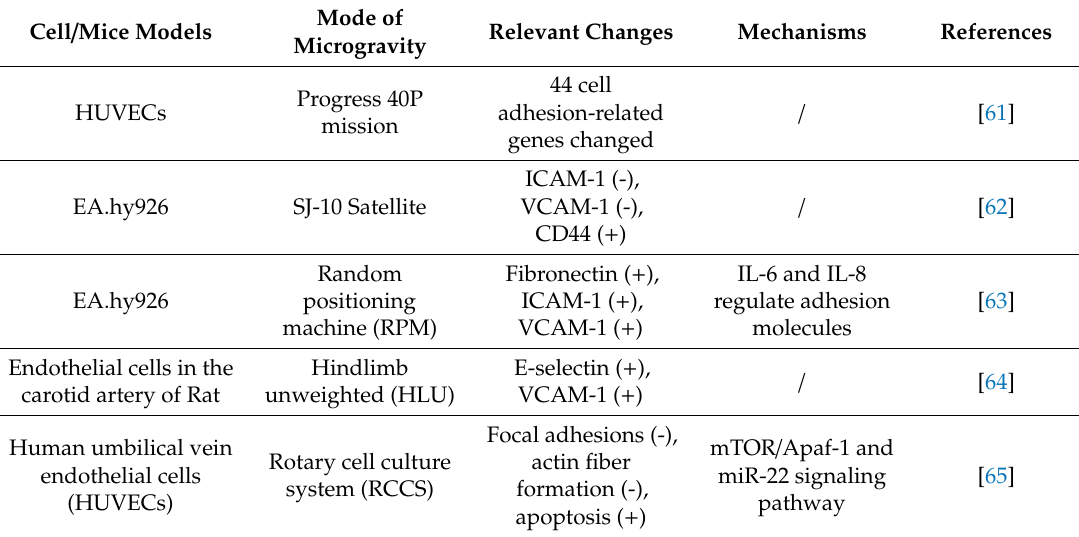
Table 2. E ff ects of microgravity on endothelial cells